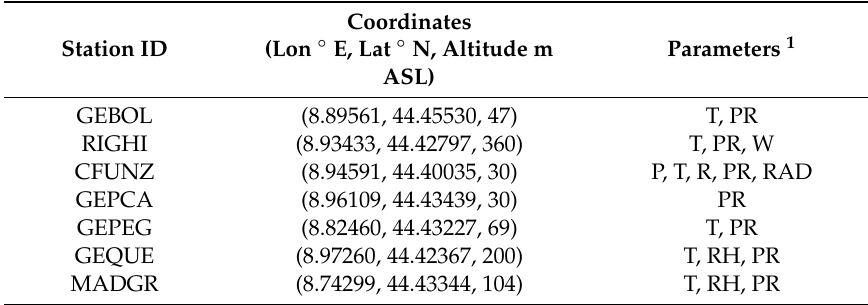
Table 1. Meteorological stations managed by the Regional Agency for Environmental Protection of Liguria Region available in the coastal area a ff ected by the thunderstorm on 14 August